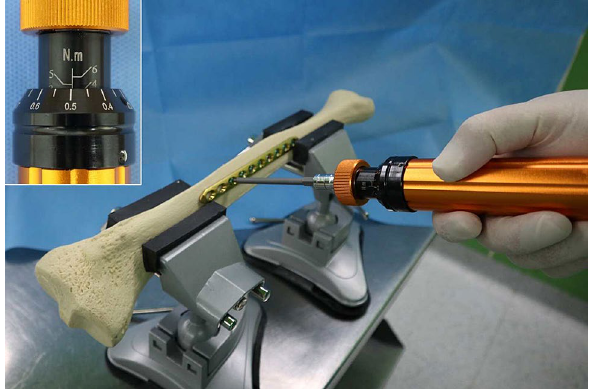
Figure 1. To overtighten and jam the locking screws into the locking plates by applying an identical torque, a torque driver with the torque limit set at 4.5 Nm was used (upper left box). A total of 120 screws were overtightened by applying an identical torque of 4.5 Nm, which exceeded the recommended torque of 1.5 Nm for the 3.5-mm locking screw